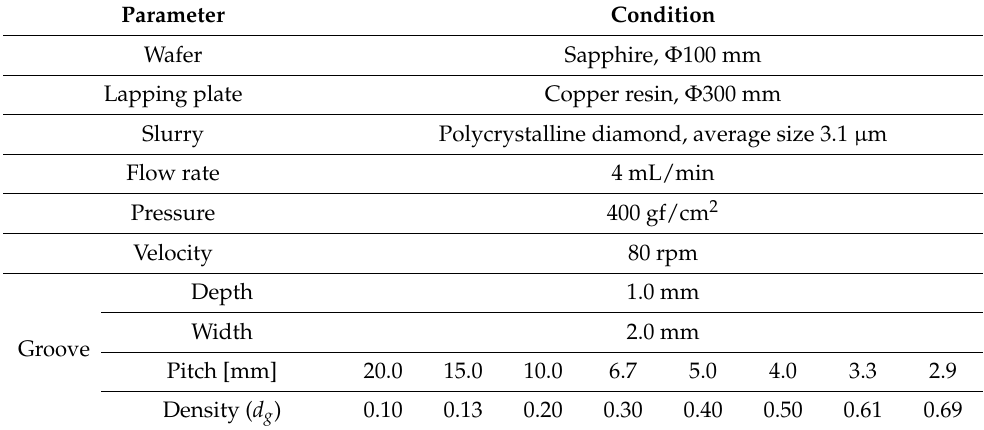
Table 1. Experimental conditions.